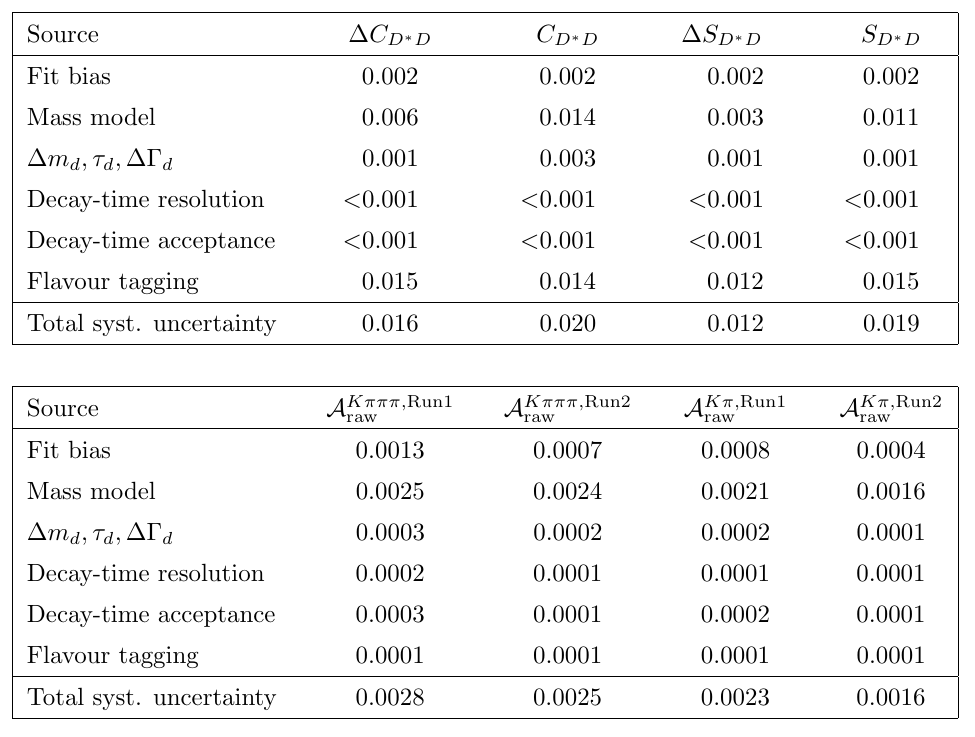
Table 4 . Summary of the systematic uncertainties. The total systematic uncertainties are com- puted as quadratic sum of individual